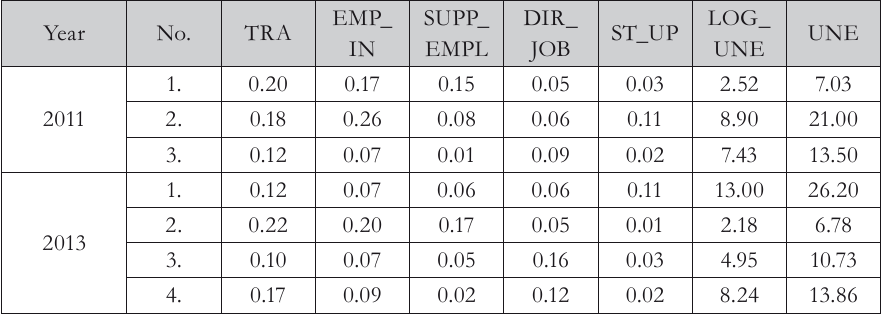
Tab. 2 – Average values of variables from clusters in 2011 and 2013. Source: Own